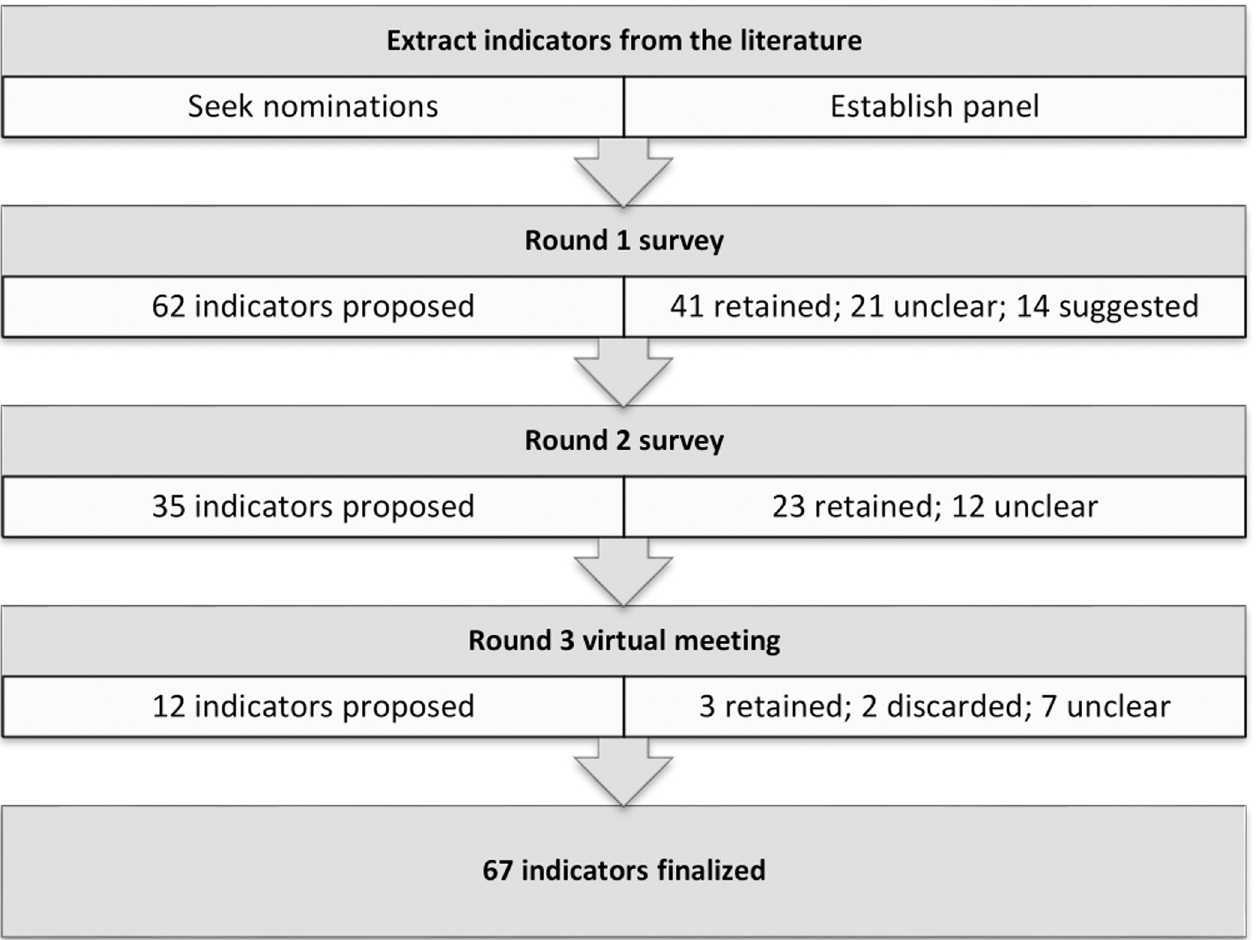
Fig 1. Modified Delphi process used to select indicators for public health emergency